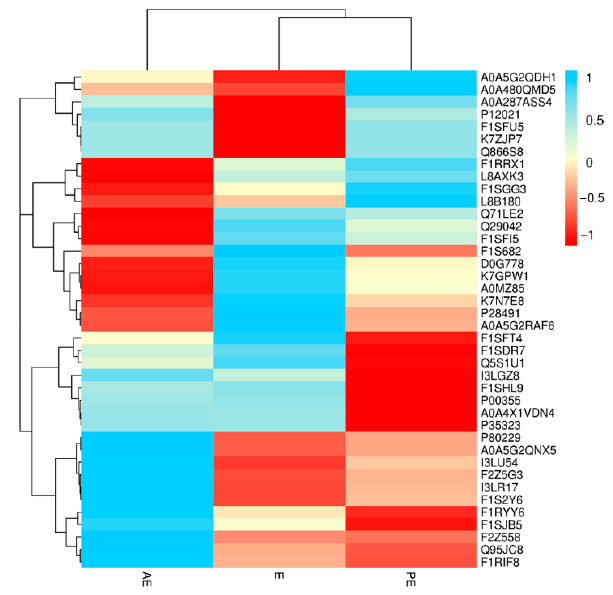
Figure 5. Heat map of salivary differential proteins in estrus cycle.